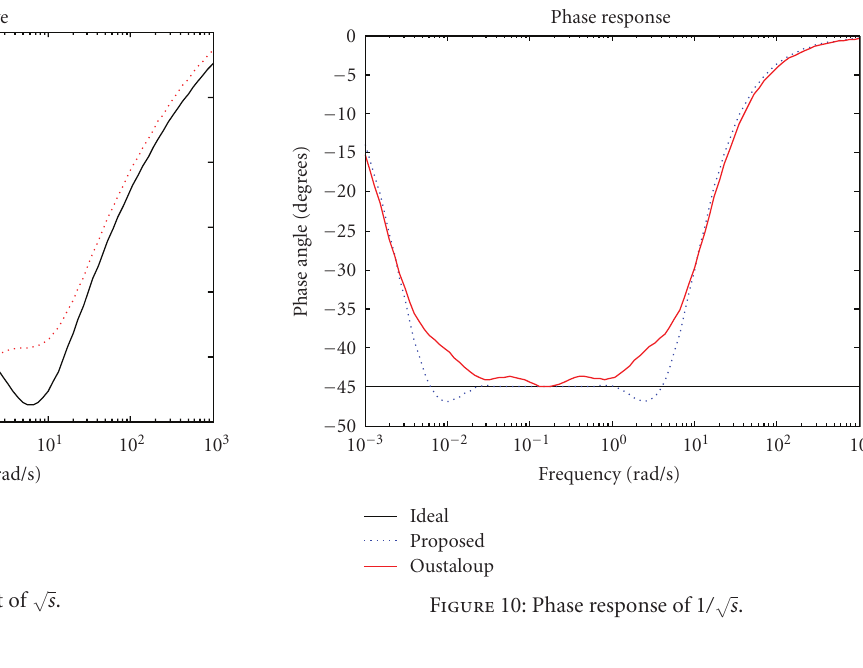
Figure 10: Phase response of 1 /